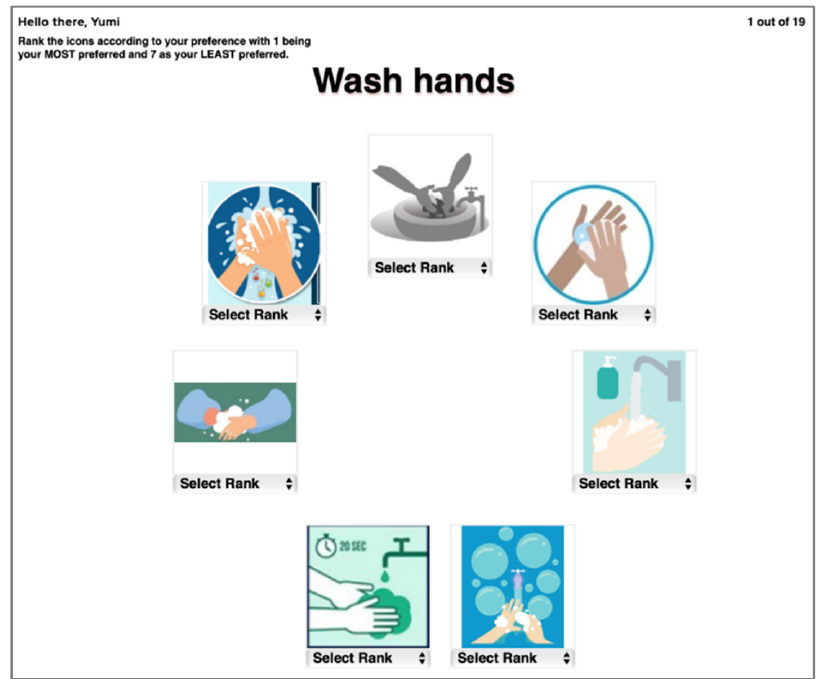
Figure 2. Example of ranking test screen.